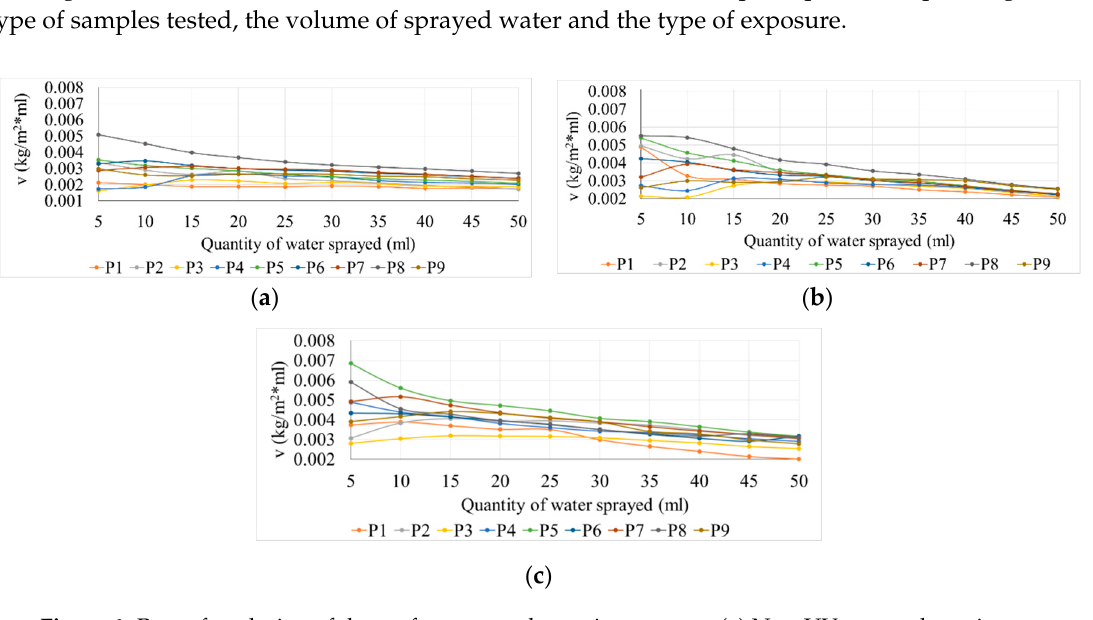
Figure 4. Rate of evolution of the surface water absorption process: ( a ) Non-UV exposed specimens, ( b ) 1 H UV exposed specimens, ( c ) 1+ 24 h UV exposed specimens.